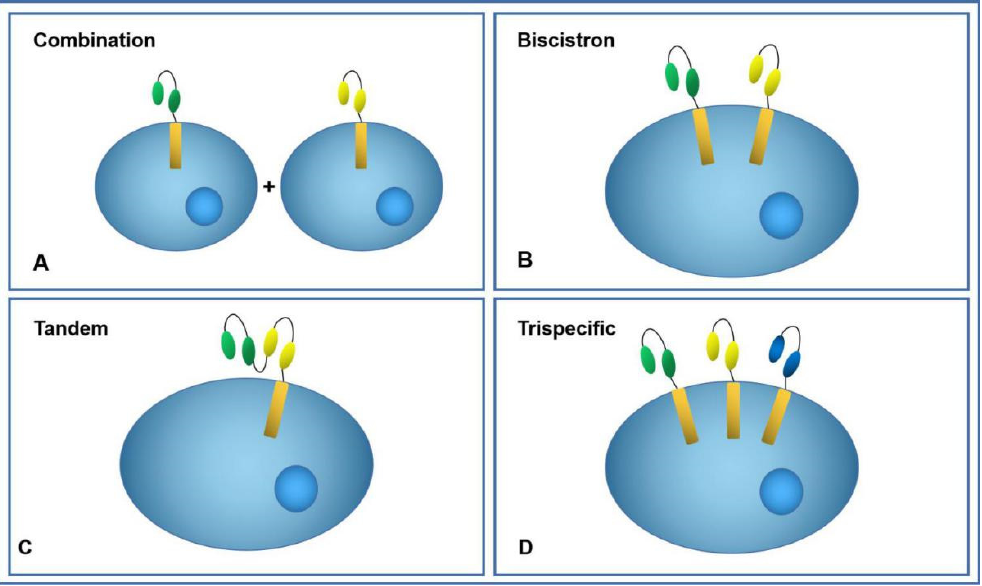
Figure 3. Multi-antigen targeted CAR-T cell. ( A ) Mixture of two independent CAR T cells. ( B ) Two different CAR structures were co-expressed in the same cell. ( C ) Two different scFvs were designed to be strung together in a single T cell. ( D ) Three different CAR structures were co-expressed in the same cell.